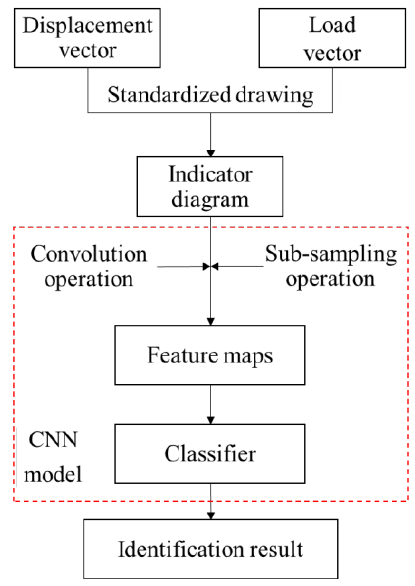
Figure 2—The process of indicator diagram identification based on